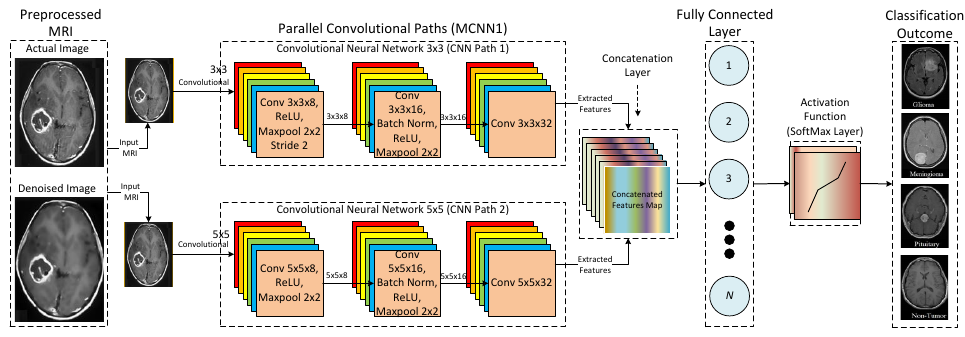
Figure 9. Detailed architecture of the proposed MCNN1.